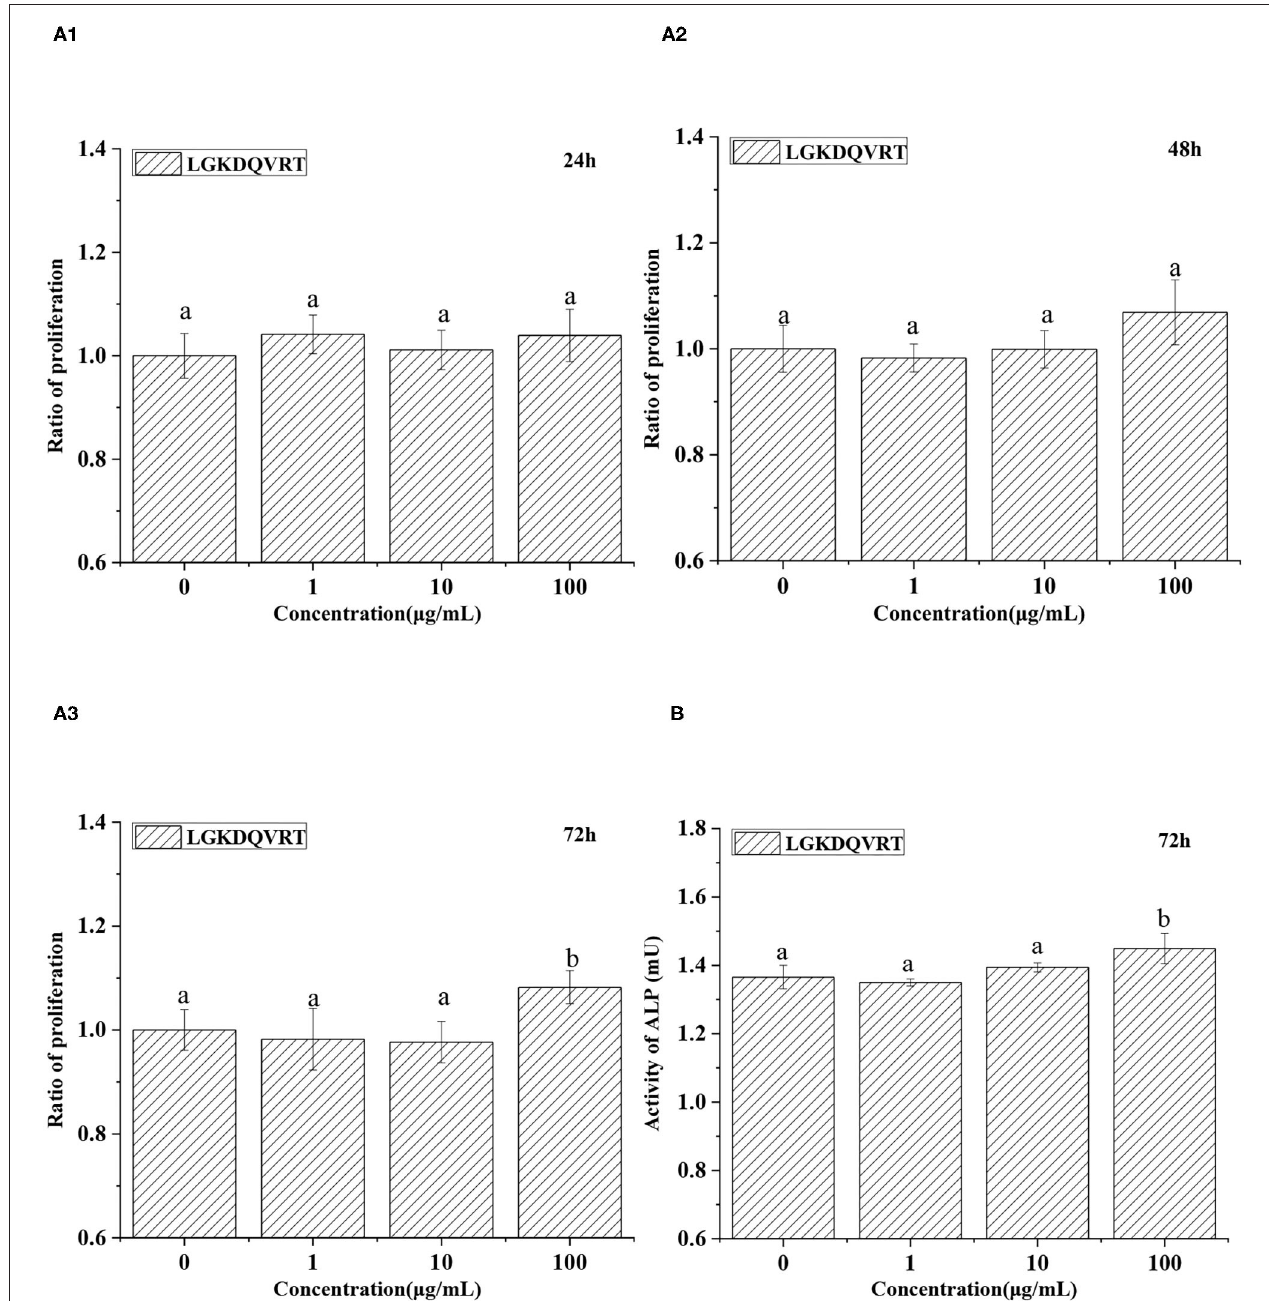
FIGURE 5 | (A) Effects of 1, 10, and 100 µ g/mL peptide LGKDQVRT for osteoblasts at 24, 48, and 72h. (B) Effects of 100 µ g/mL peptide LGKDQVRT for osteoblasts on ALP activity at 72h. All statistical tests ( n = 6) were conducted, and values designated by different letters are considered significantly different ( p < 0.05).